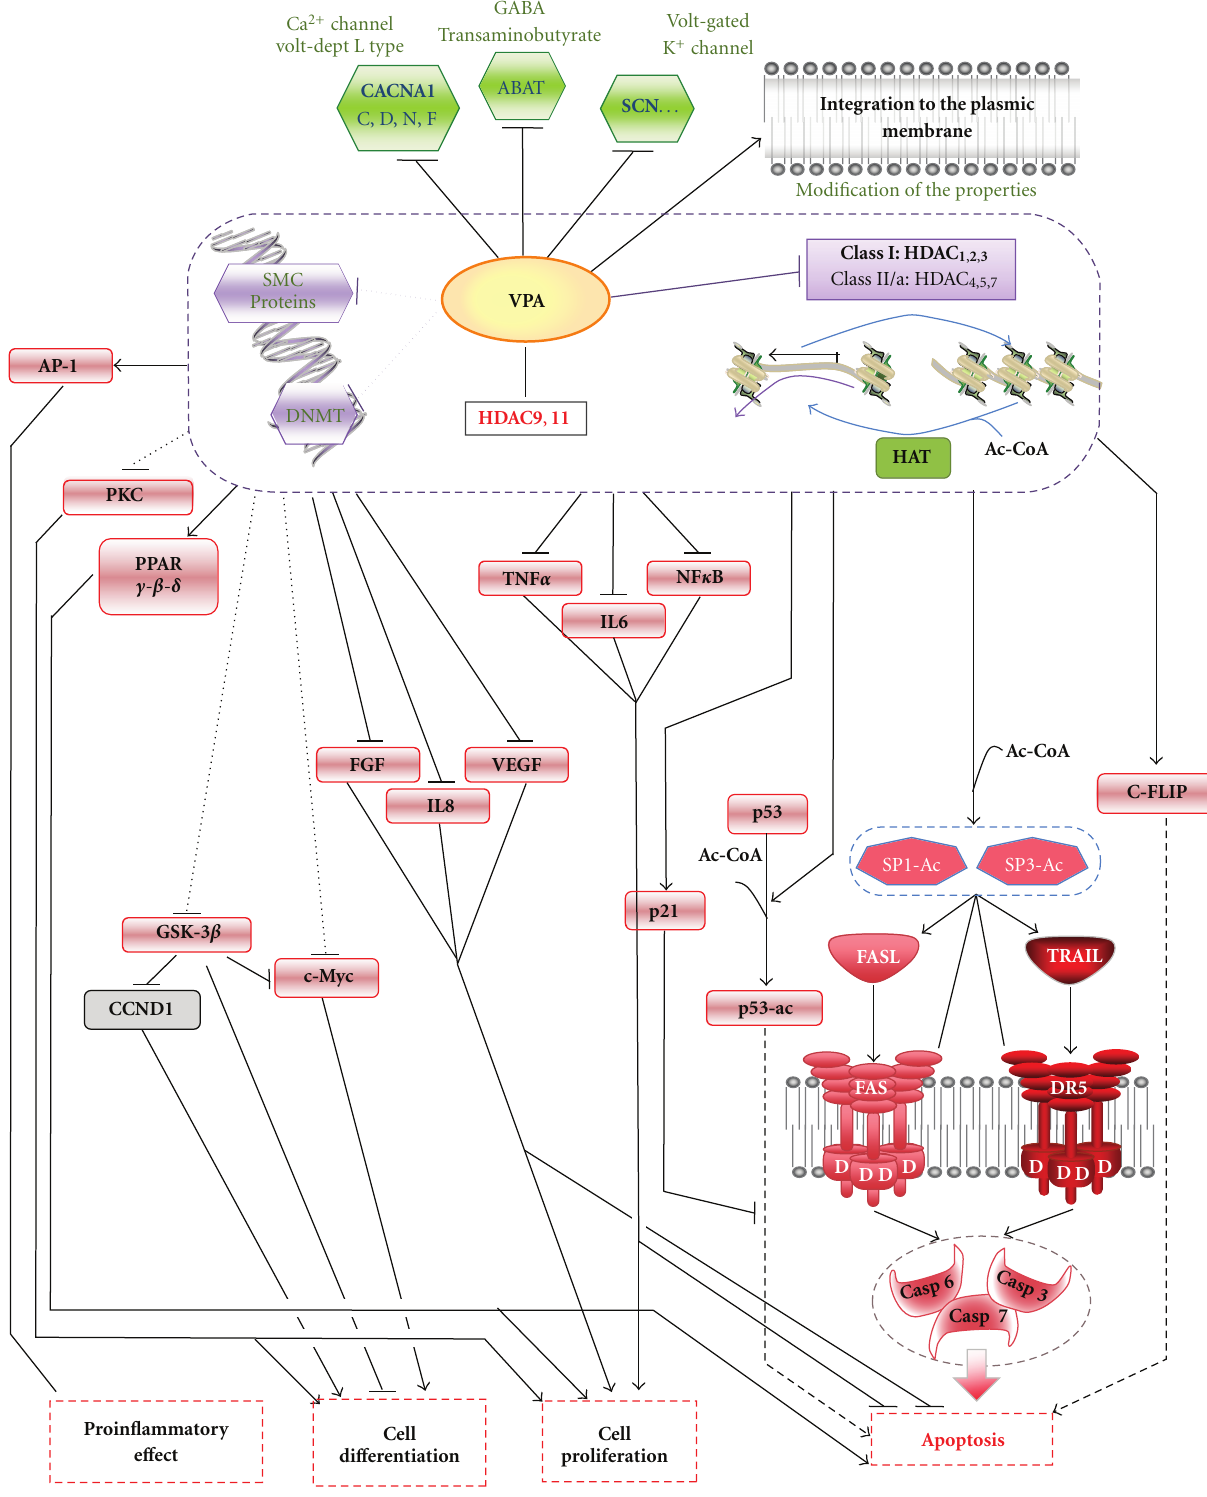
Figure 2: Pharmacological activity of VPA described in the literature. Schematic representation of direct and indirect targets of VPA. Principal direct targets known for VPA are ionic channels and ABAT (in green). Epigenetic action of VPA (in violet) as HDACi activity: VPA targets the transcriptomic system and principally directly inhibits HDAC class I (subcategories 1, 2, and 3), and less strongly class II/a (subcategories 4, 5, and 7), but induces HDAC 9 and 11, and indirectly inhibits the function of SMC and DNMT. Probably due to its epigenetic properties, or interactions not yet established, VPA alters, directly or indirectly, expression of many molecules involved in molecular pathways such as apoptosis, inflammation, di ff erentiation, and proliferation (in